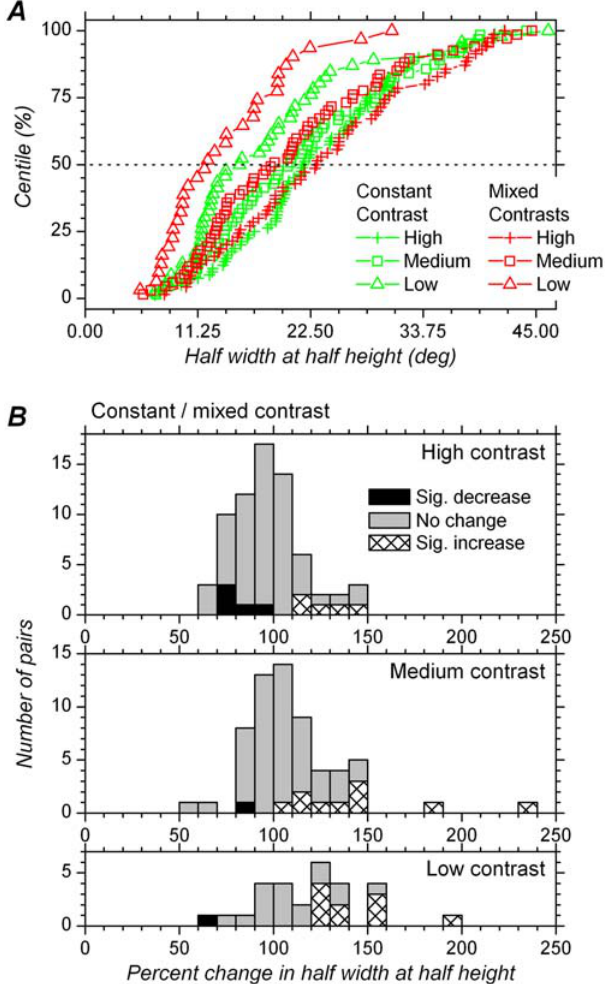
Figure 11. The effects of contrast and contrast adaptation on HWHH. A. Cumulative distribution of HWHH. Data in red were obtained with the mixed contrasts block and data in green obtained with constant contrast blocks. The effect of matched contrast adaptation is a narrowing of the distributions, with the largest shift observed for the low contrast. B. Distributions of percent change in HWHH for one contrast in two stimulation regimes. HWHH obtained in the constant contrast block for a given contrast (matched adaptation) is expressed as a percentage of the one obtained for the same contrast in the mixed contrasts block (mismatched adaptation). Cells showing significant (t-test, p , 0.05) decrease in HWHH with adaptation to constant contrast are indicated in black, and cells showing significant increase in HWHH by hachure. Upper histogram: adaptation to high contrast resulted in a small but significant reduction of HWHH compared to adaptation to mixed contrasts (median: 96.3%). Middle histogram: adaptation to medium contrast resulted in a small but significant increase in HWHH compared to adapting to mixed contrasts (median: 105.0%). Lower histogram: adaptation to low contrast resulted in a significant and larger increase in HWHH compared to adapting to mixed contrasts (median: